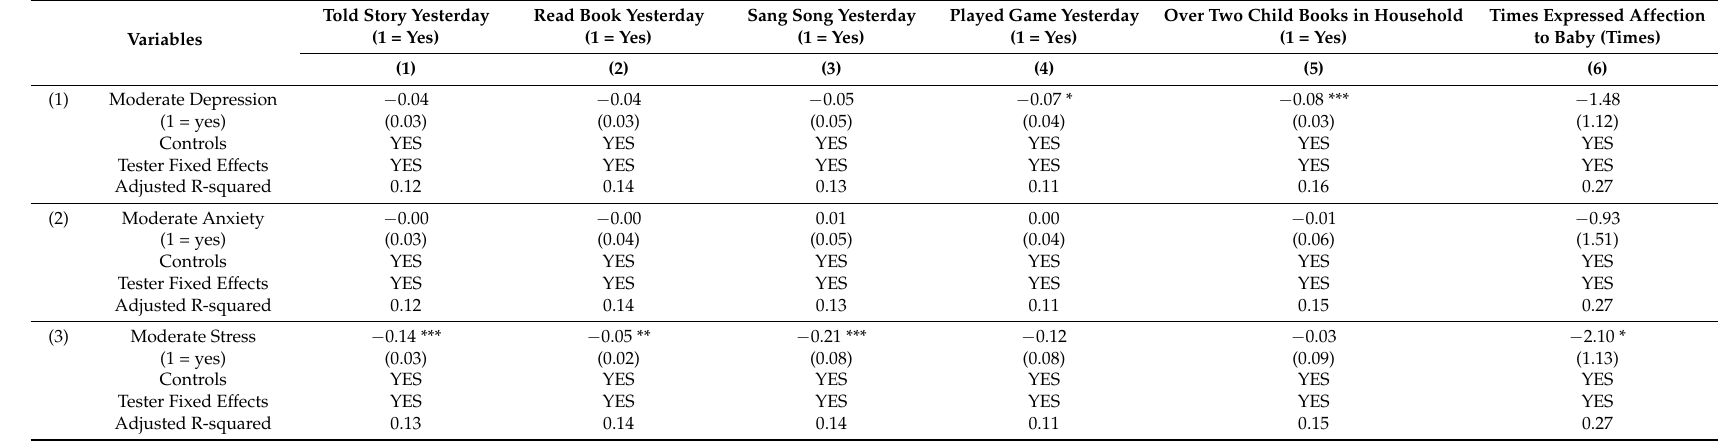
Table 7. Correlations between caregiver’s mental health and positive parenting practices using ordinary least squares, n = 2514.